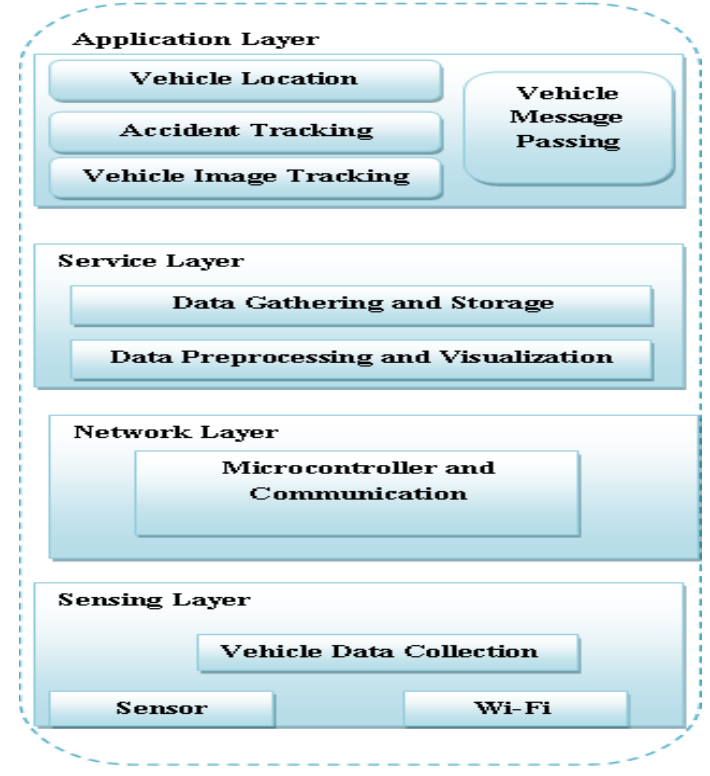
Figure 3. Layered architecture of the proposed ATM model.